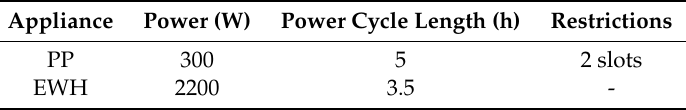
Table 3. The parameters of the IN appliances.